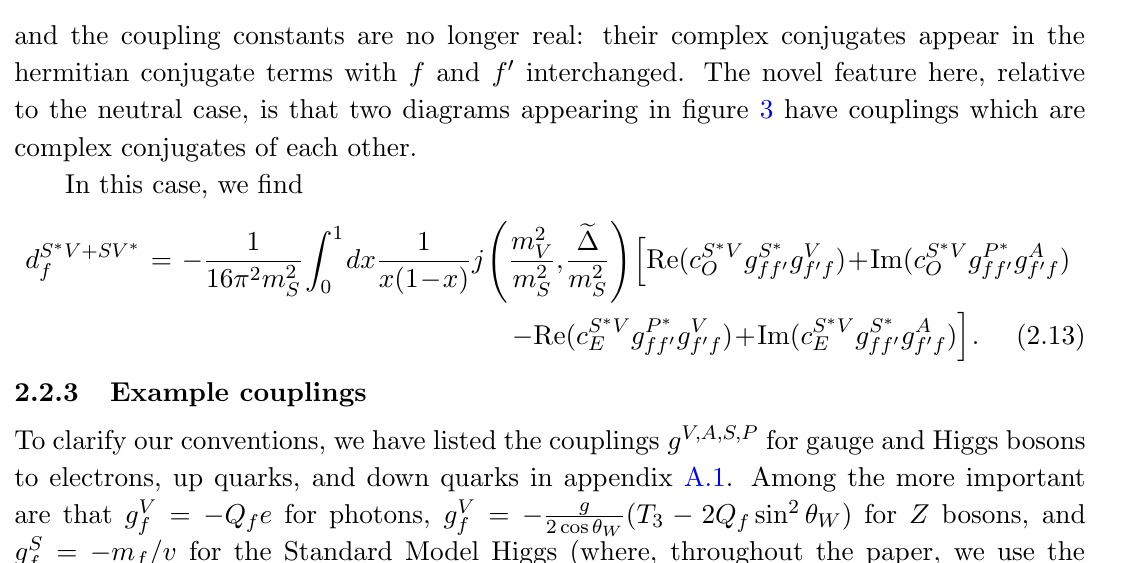
Figure 4 . Scalars (cid:30) and ! running in the inner loop to produce an e(cid:11)ective (cid:13)S (cid:3) V vertex. If (cid:30) and ! are indeed distinct, there are two additional diagrams with exchanged labels (cid:30) $ ! . In the case V = W (cid:6) , there are additional diagrams involving a W + W (cid:0) (cid:13) vertex (see e.g. [18]), which are necessary to obtain a gauge-invariant